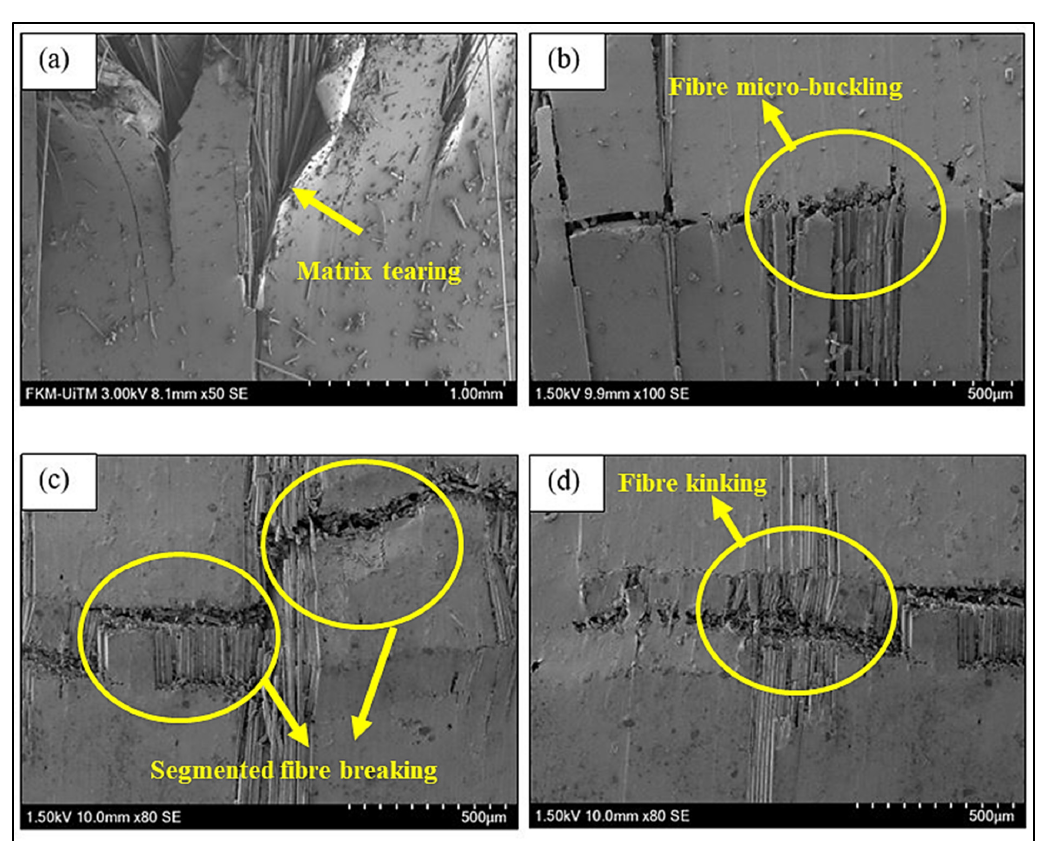
Figure 6. SEM Micrographs of unmodified BFRP composite showing the ( a ) matrix torn and detached from fibre, ( b ) fibre micro buckling, ( c ) matrix cracking and fibre breakage and ( d ) fibre kinking mechanisms.